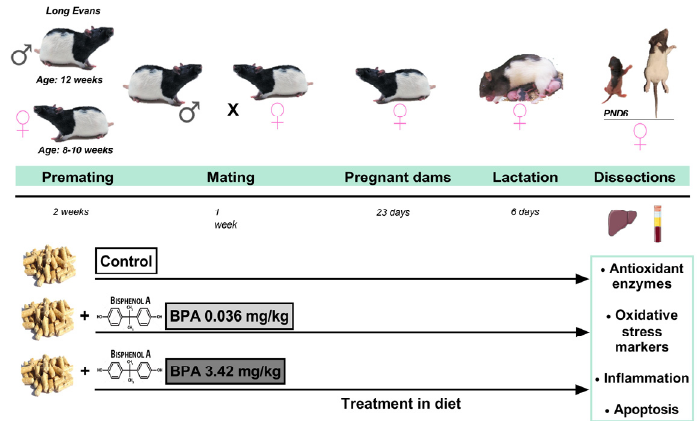
Figure 11. Experimental design. The diet of the parental generation (F0) was different according to the experimental group (control, BPA 0.036 mg/kg and BPA 3.42 mg/kg). During the entire experiment (premating, mating, pregnancy, lactation), the treatment was maintained until the time of dissection in dams and pups to postnatal day 6 (PND6). The influence of lactating dams and perinatal exposure to BPA on livers and its possible mechanism in offspring were studied. Figure created with Prism v7 (GraphPad Software Inc., La Jolla, CA, USA).